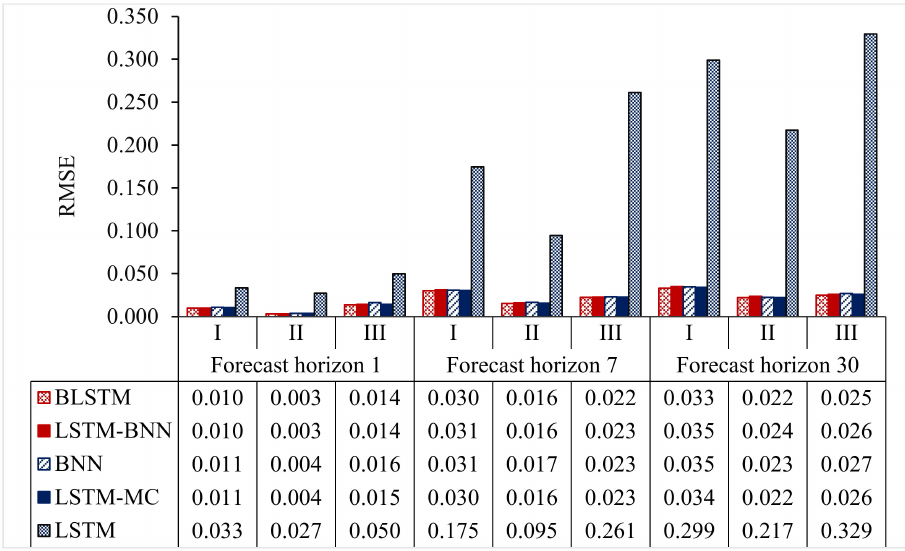
Figure 4. Comparison among prediction models in terms of